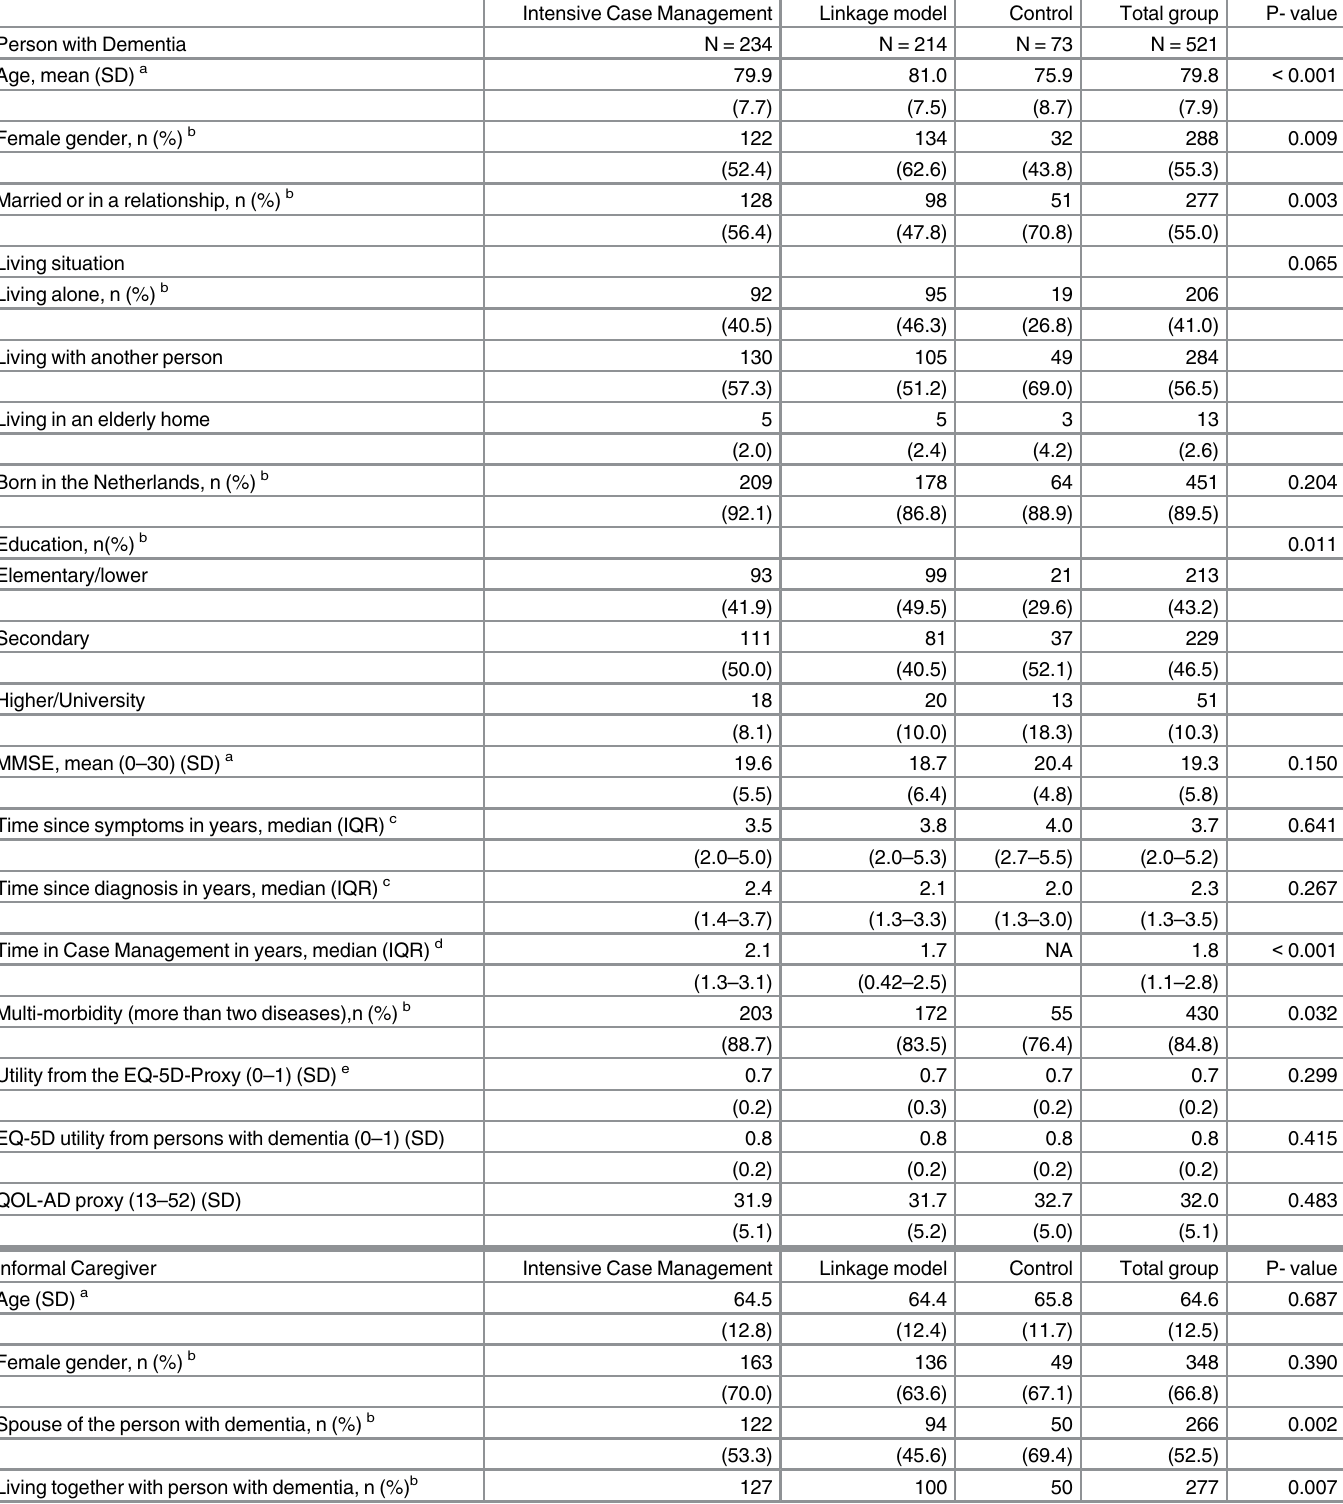
Table 1. Baseline table of characteristics of care models, persons with dementia and informal